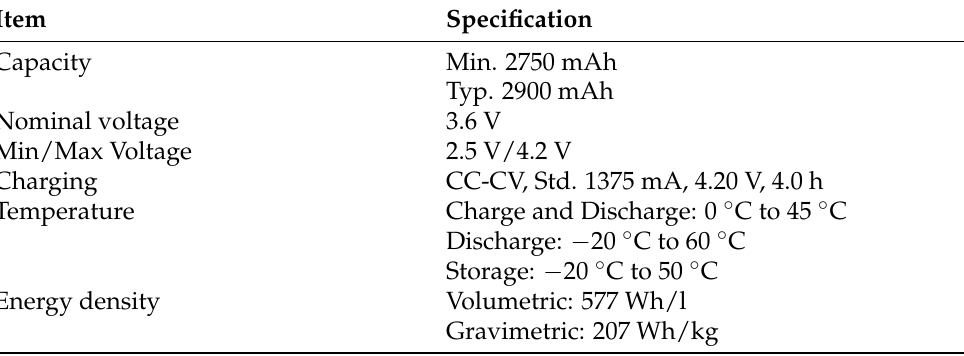
Table 1. The specification of the Panasonic 18650PF battery